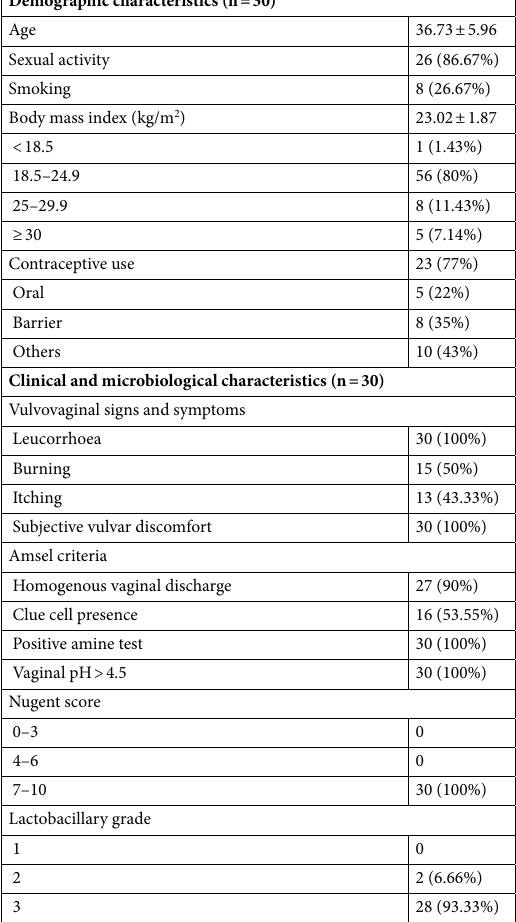
Table 4. Demographic and clinical characteristics of the study sample (n = 30). Data are presented as both absolute number and percentages . Age and body mass index are expressed as mean and standard